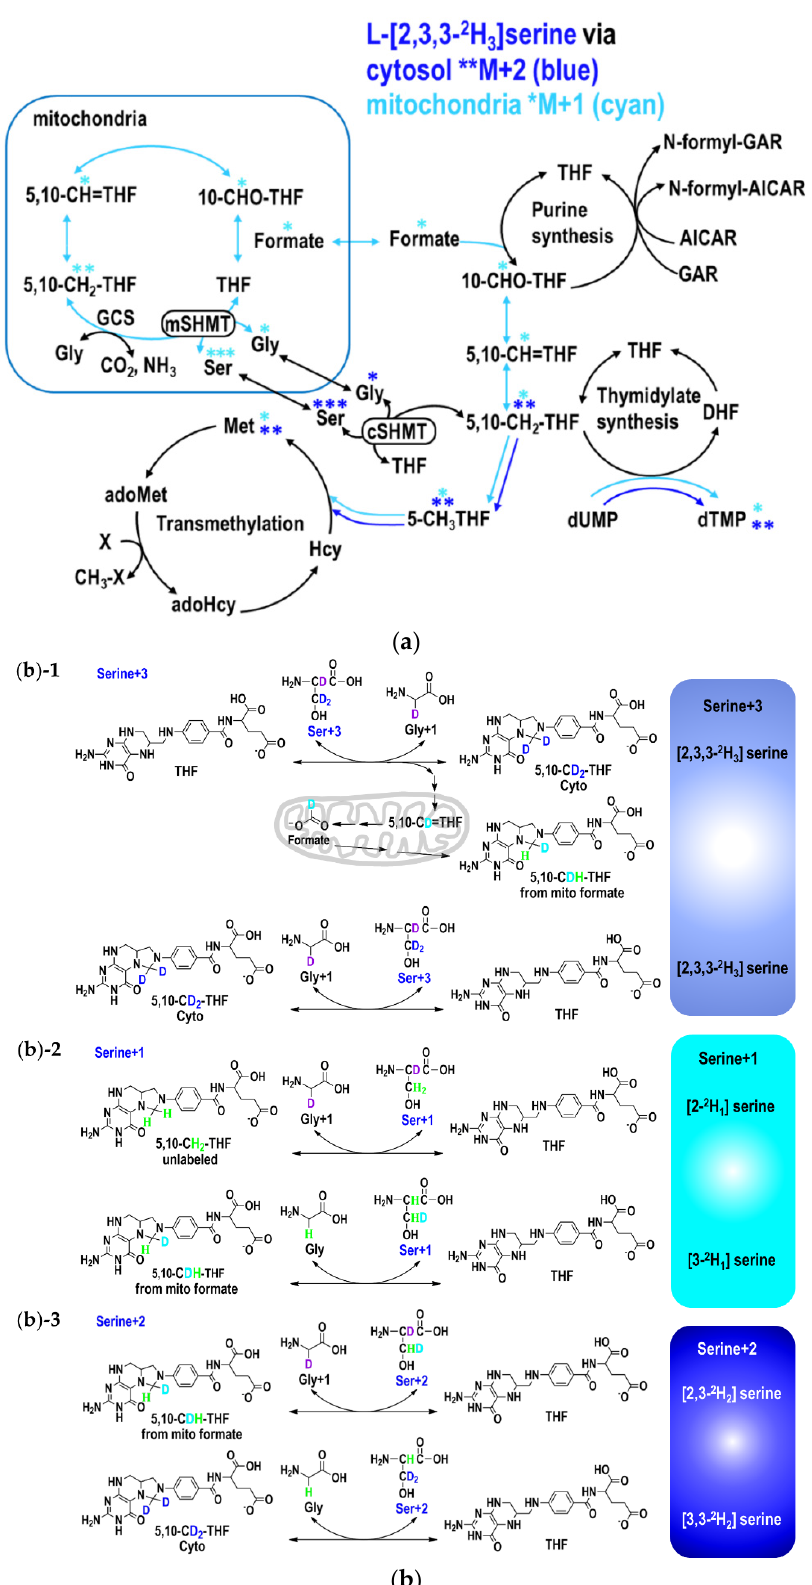
Figure 7. ( a ) Tracing the partitioning of 1 carbon flux between mitochondrial and cytosolic derived one carbon moiety via L-[2,3,3- 2 H 3 ]serine. L-[2,3,3- 2 H 3 ]serine tracer enables distinguishing mitochondrial (shown in cyan M+1) derived one carbon moiety from cytosolic (blue M+2) counterpart. On the lower right, generation of de novo [ 2 H 1 ]-thymidine from mitochondria-derived formate via mitochondrial serine hydroxymethyl-transferase (mSHMT) and de novo [ 2 H 2 ] thymidine